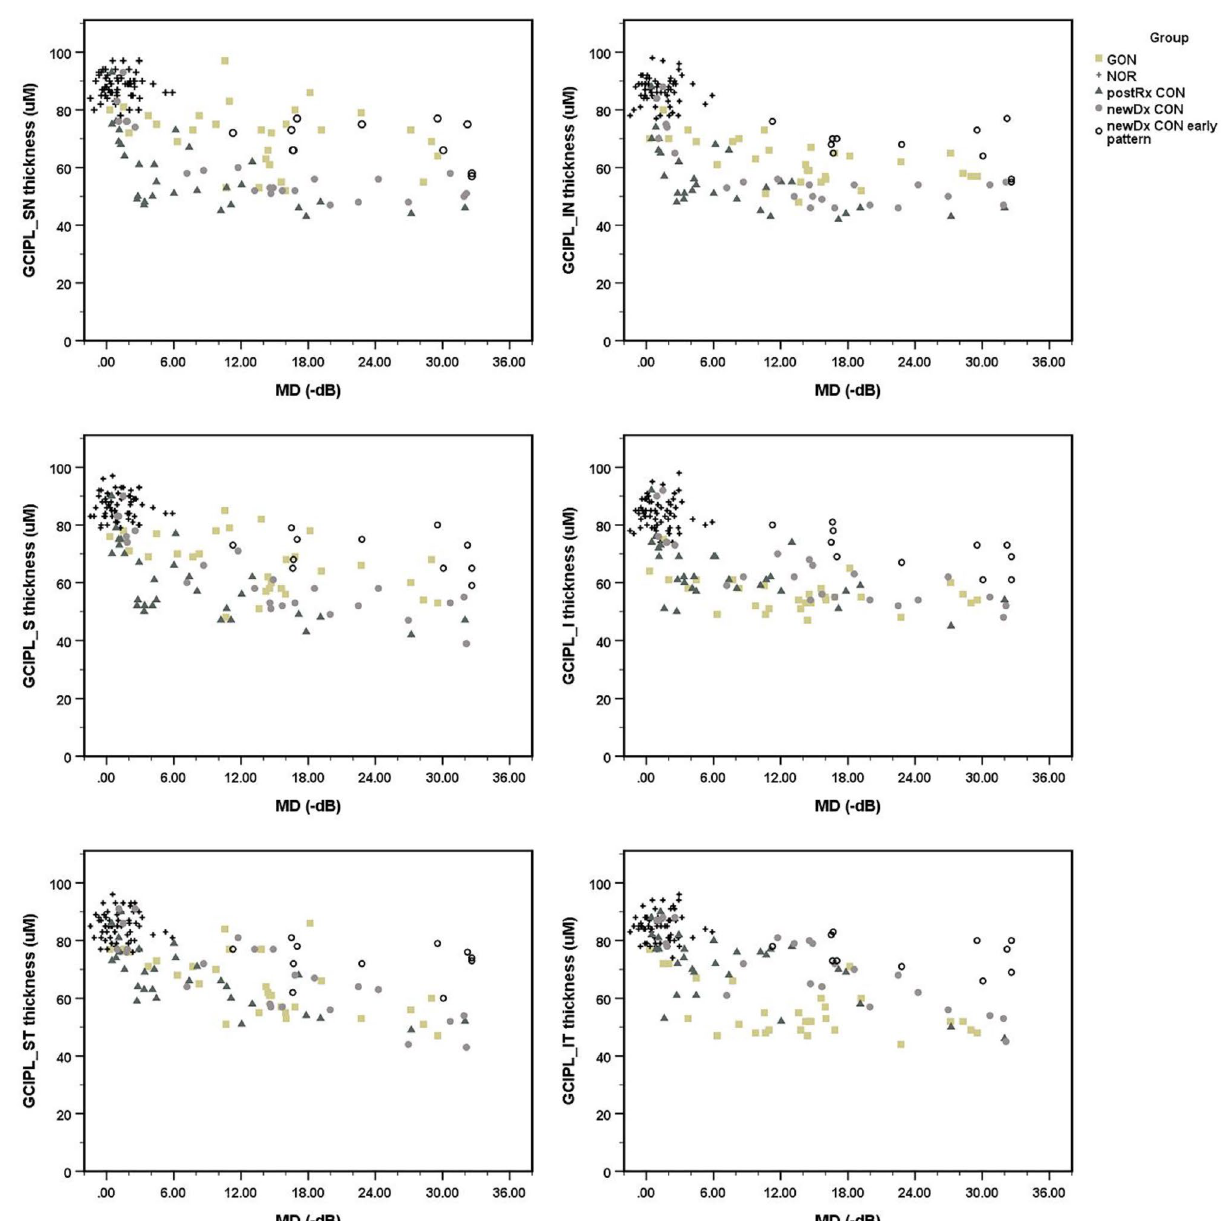
Figure 2. The scatter plot illustrates the distribution of cross-sectional data between macular GCIPL OCT parameters from individual cases versus the corresponding MD index of visual losses of each diagnostic group and control. GON glaucomatous optic neuropathy, CON compressive optic neuropathy, NOR healthy control, postRx post-treatment, newDx newly diagnosed, newDx CON Early pattern 11 of 34 newly diagnosed CON eyes show apparent disproportionally milder degree and or earlier pattern of structural thinning compared to the associated visual field losses, GCIPL macular ganglion cell-inner plexiform layer parameter, SN supero-nasal sector, IN infero-nasal sector, S superior sector, I inferior sector, ST supero-temporal sector, IT infero-nasal sector, uM micrometer, MD mean deviation, dB losses. These VF losses were readily recognized for moderate to high MD losses, where the associated pattern and degree of VF losses were advanced. These cases are labeled “newly diagnosed CON with early pattern” in Figs. 1 and 2. The structure–function relationship of 30 posttreatment CON generally showed a higher degree and a later pattern of structural thinning than an improved VF function, with an approximately left-lower shift, compared with the newly diagnosed CON cases (Figs. 1 and 2). Most posttreatment CON showed moderate to good recovery of VF function with a disproportionally more severe structural thinning profile. Most post- treatment CON eyes still showed a remnant feature of preferential thinning of the nasal versus temporal sector, which was seen in most newly diagnosed CON eyes. A few cases of posttreatment CON had a remarkably severe thinning profile with an undifferentiated thinning pattern, yet with an excellent recovery of the VF function.